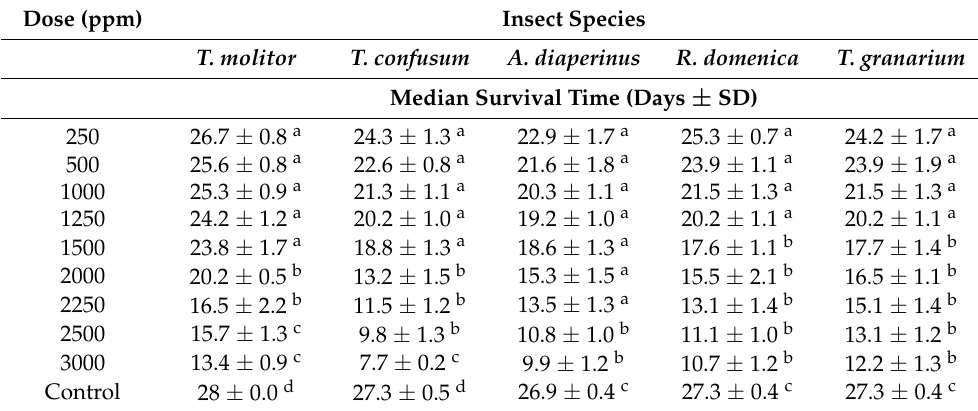
Figure 2. Mean mortality (% ± SD) of T. confusum adults sprayed with six concentrations of cyantraniliprole after 28 days. Table 1. Median survival time (Days ± SD) of insect species adults. Mean ± SD values with the same letter within a column are not significantly different ( p <